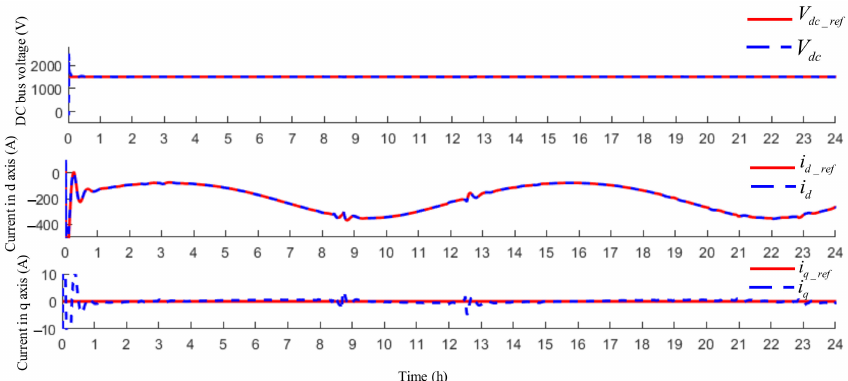
Figure 7. DC bus voltage and d–q axis current of